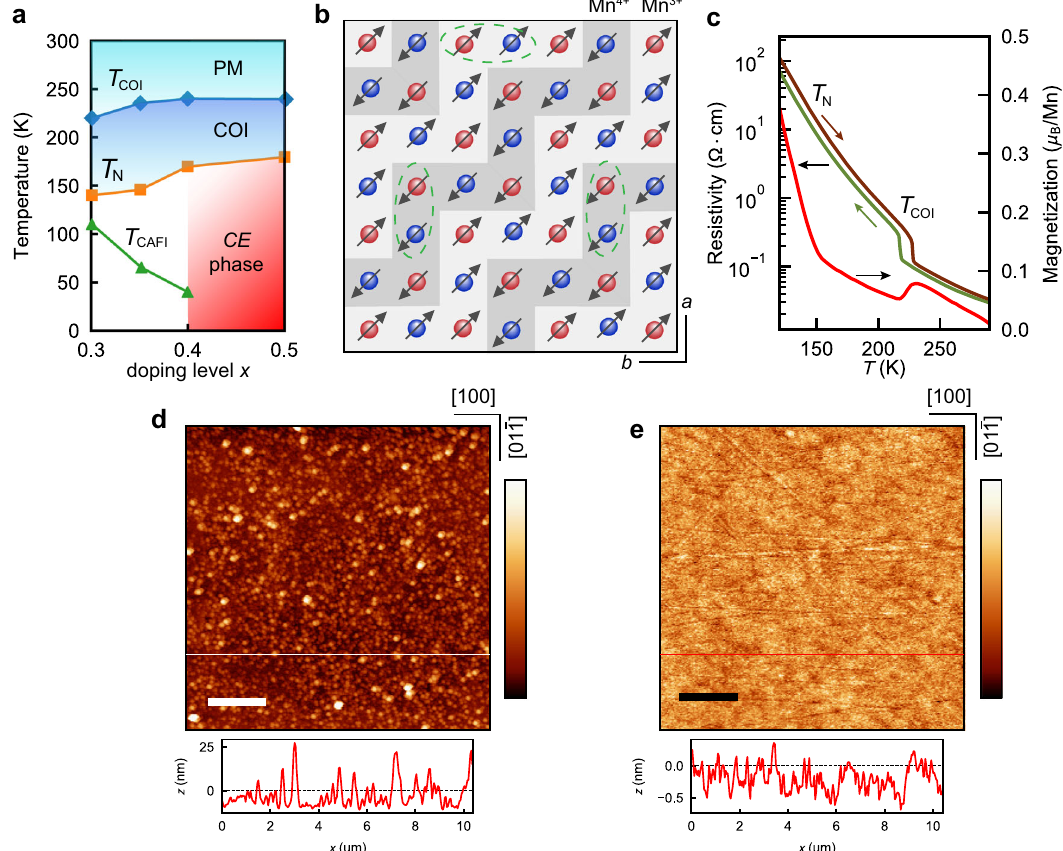
Fig. 1 Phase diagram, electrical, and magnetic properties of PCMO. a Phase diagram of Pr 1 − x Ca x MnO 3 as a function of the doping level x adapted from ref. 4 . PM, COI, and CAFI denote the paramagnetic insulator, charge-ordered insulator, and canted antiferromagnetic insulator phase, respectively. b Schematic illustration of the charge and spin ordering in the CE phase. The ferromagnetic zigzag chains are shown by the gray and light gray zigzag regions. The green-dashed ovals indicate the Zener polarons. c The temperature dependence of the resistivity and magnetization of the imaged PCMO fi lm. The resistivity was measured in zero fi eld and the magnetization was measured in 0.1 T applied along [100] axis with the diamagnetic response of the substrate subtracted. d – e Rough and fl at topography observed in this fi lm at different locations. Image size: 10.4 × 10.4 μ m 2 . Scale bar in d and e : 2 μ m. Color scale: 60 nm ( d ) and 2.2 nm ( e ).